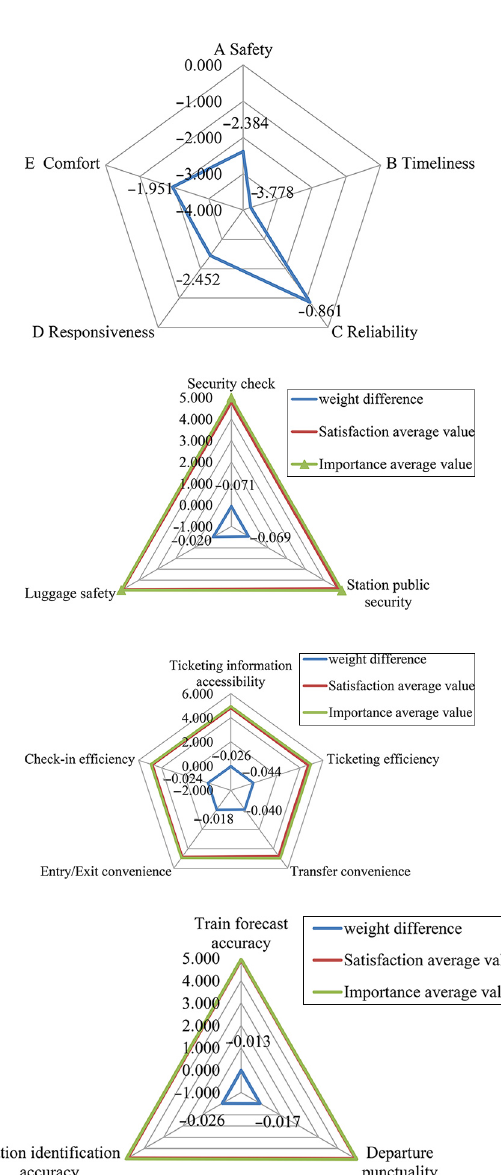
Figure 4. Weight differences of reliability